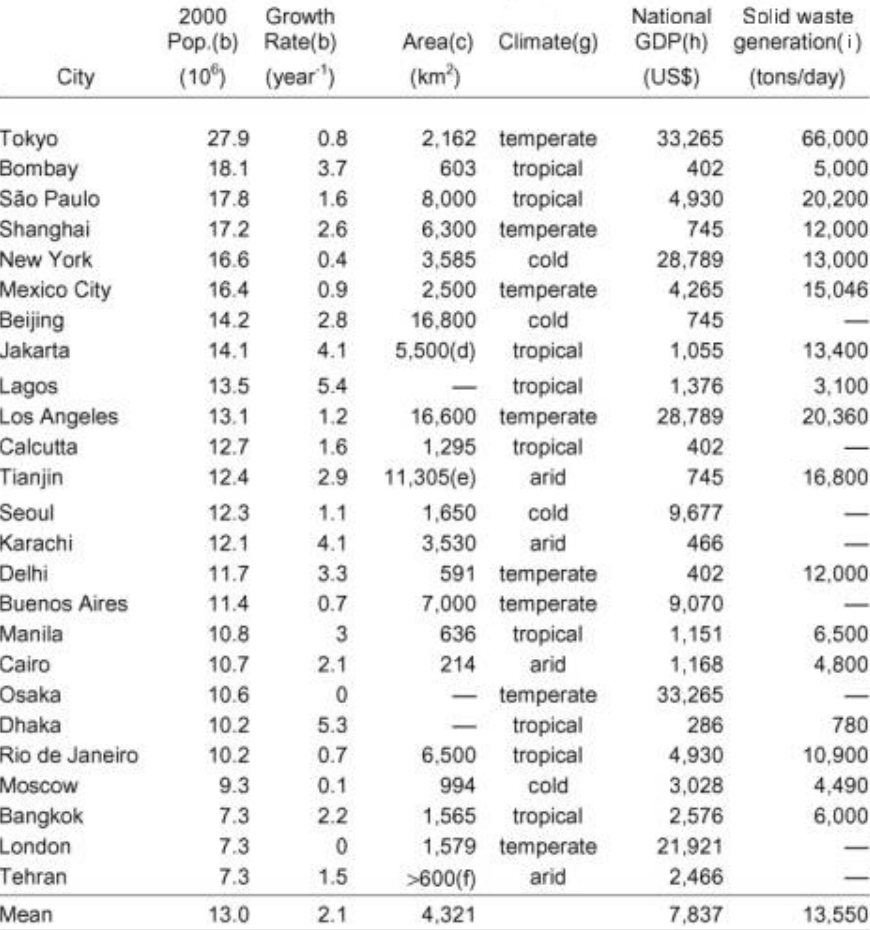
Demographic and Socioeconomic Indicators of the World’s Megacities